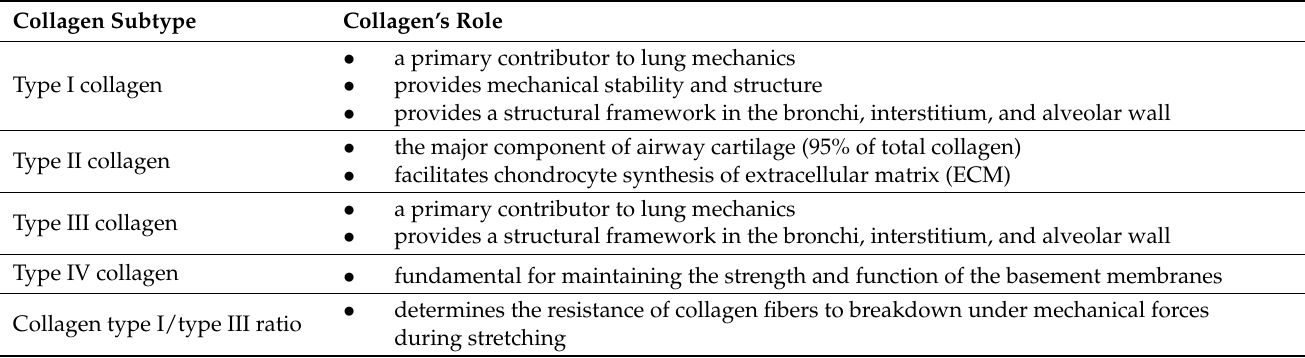
Table 1. Role of the different types of collagen in